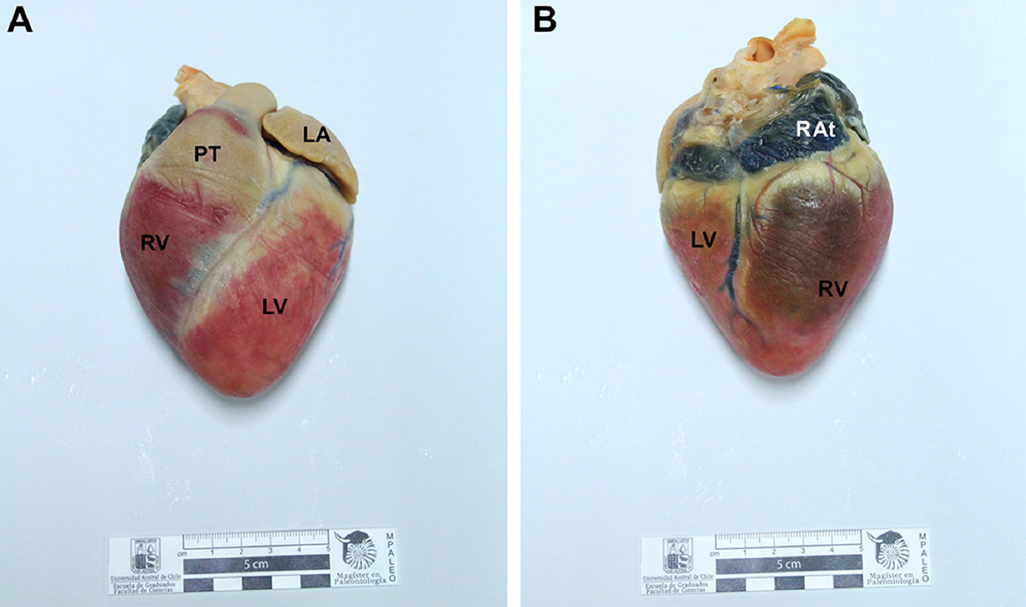
Figure 1. Photograph of the left side of an equine heart ( facies auricularis ) preserved and stained by the modified Elnady technique. A window opening in the left ventricle (white arrow). A: Aorta; LA: Left auricle; TB: Brachiocephalic trunk; PT: Pulmonary trunk; LV: Left ventricle; RV: Right ventricle. Red color in the ventricles is clearly observed in the organ.